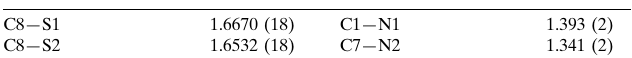
Selected bond lengths (A˚ ).